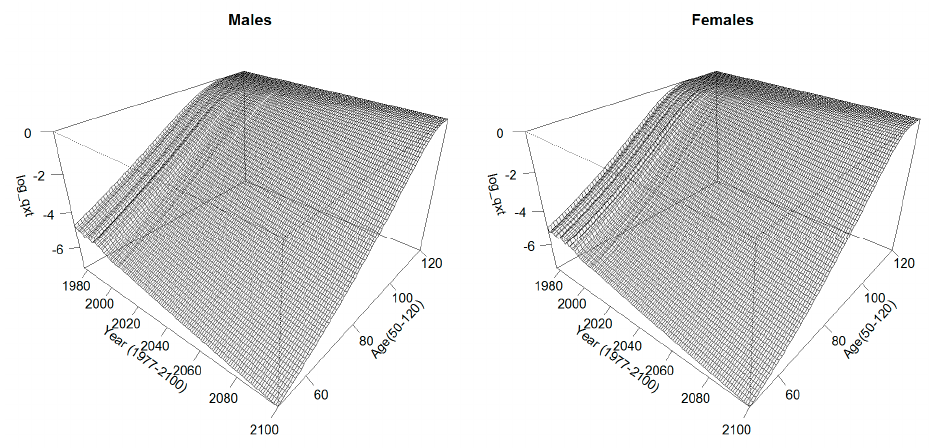
Figure 9. Coherent mortality projected surfaces for males and females (ASMRs).